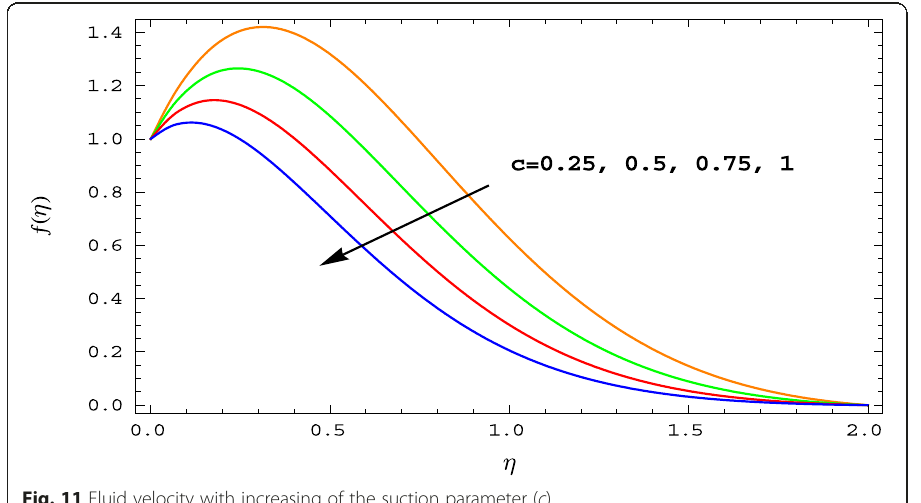
Fig. 11 Fluid velocity with increasing of the suction parameter ( c